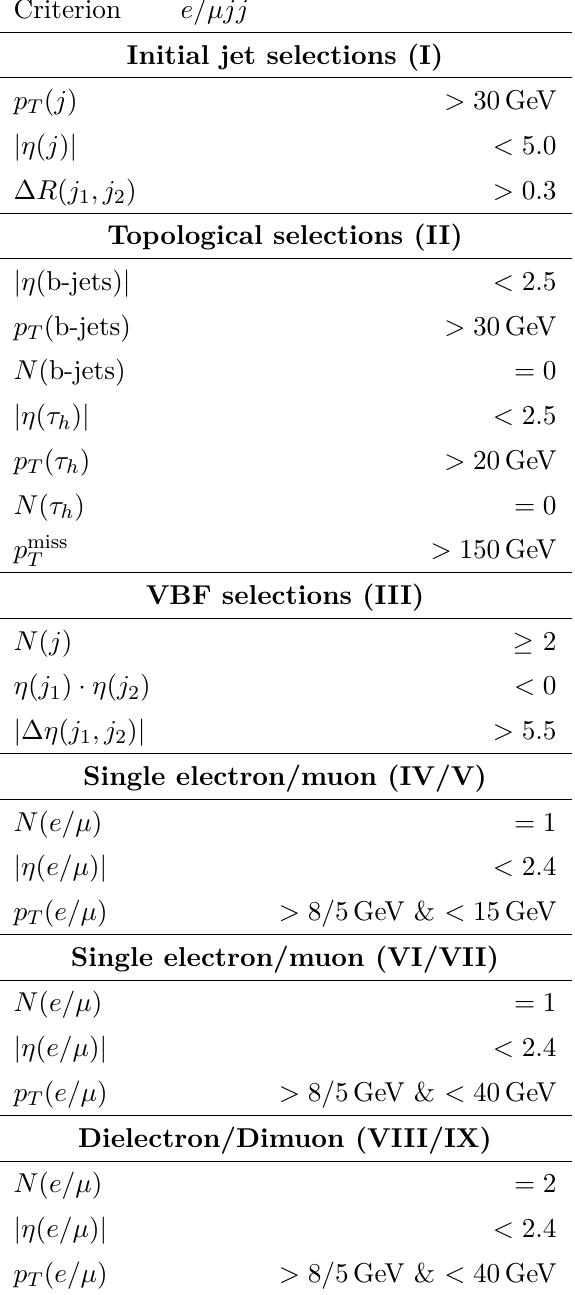
Table 3 . Event selection criteria to maximize discovery potential at the LHC, for the single-lepton (single electron and single muon) and the dilepton (dielectron and dimuon)